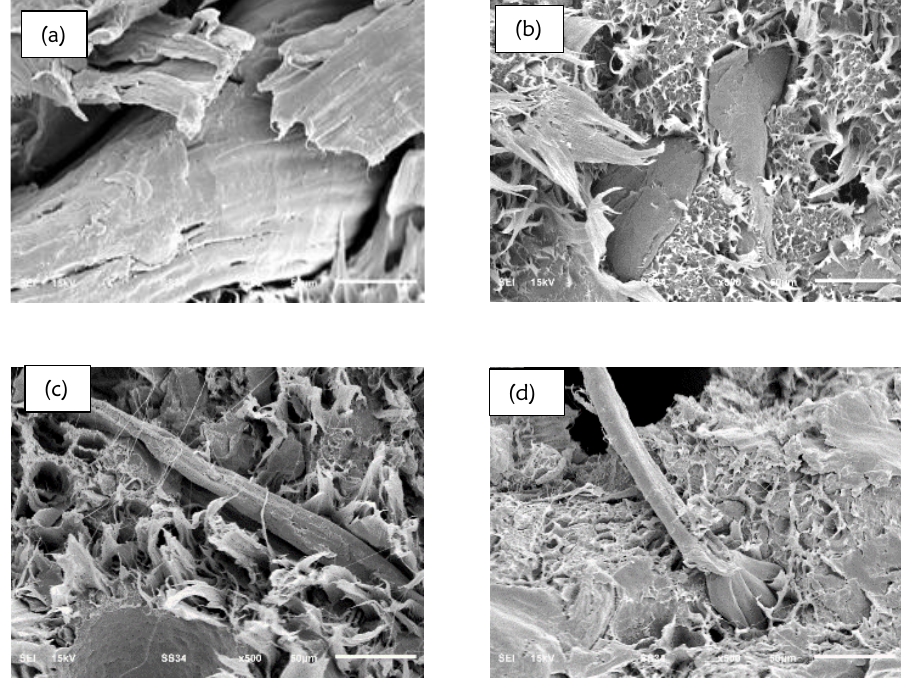
Figure 4: SEM micrographs for unexposed UV of HDPE/DSF composite (a) without MAPE, (b) with MAPE, and UV exposure (c) without MAPE, (d) with